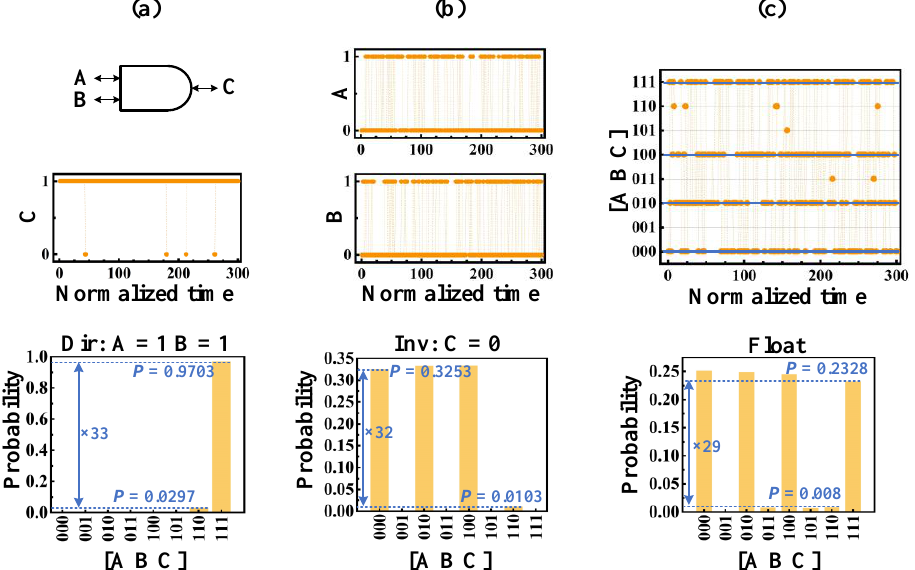
Figure 6. Invertible AND gate operation. ( a ) Directional mode: Clamping the inputs ( A , B ) to (1,1), the time-dependent output of C for the AND gate (top), the statistics collected for 10 6 samples (bottom); ( b ) inverse mode: Clamping the outputs C to 0, time-dependent outputs of ( A , B ) for the AND gate (top), the statistics collected for 10 6 samples (bottom); ( c ) floating mode: All the inputs and output are floating, time-dependent nodes of ( A , B , C ) for the AND gate (top), the statistics collected for 10 6 samples (bottom).